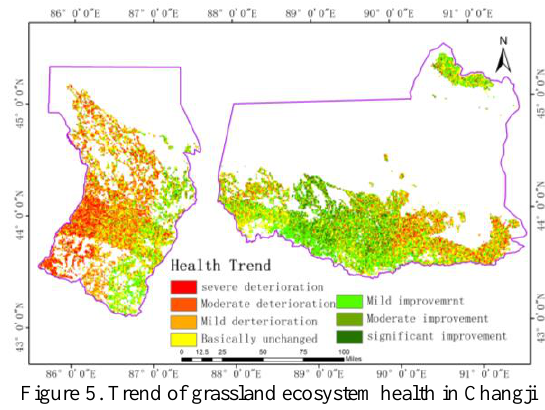
Figure 5. Trend of grassland ecosystem health in Changji prefecture between 2000 and 2016 Based on the analysis of grassland health trends in Changji Pref ecture, grassland health trends in the counties and cities under t he jurisdiction of Changji Prefecture were analyzed with the sa me range of slope values, including grassland health in Changji City, Fukang City, Jimsar County, and Qitai County. With